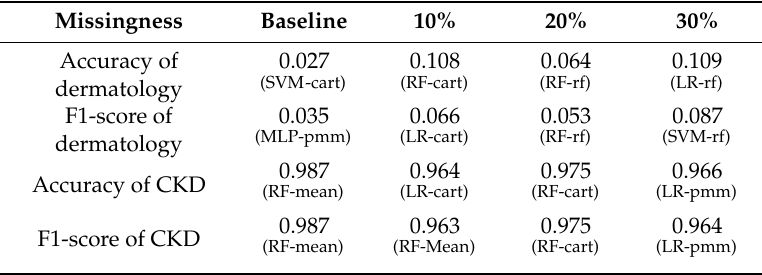
Table 6. Best results of datasets based on traditional machine learning.